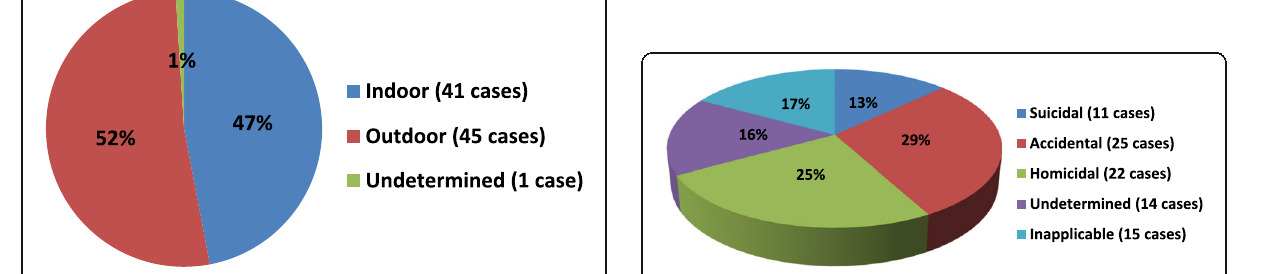
Fig. 5 Distribution of cases according to the manner of the crime Fig. 4 Distribution of cases according to the place of child death